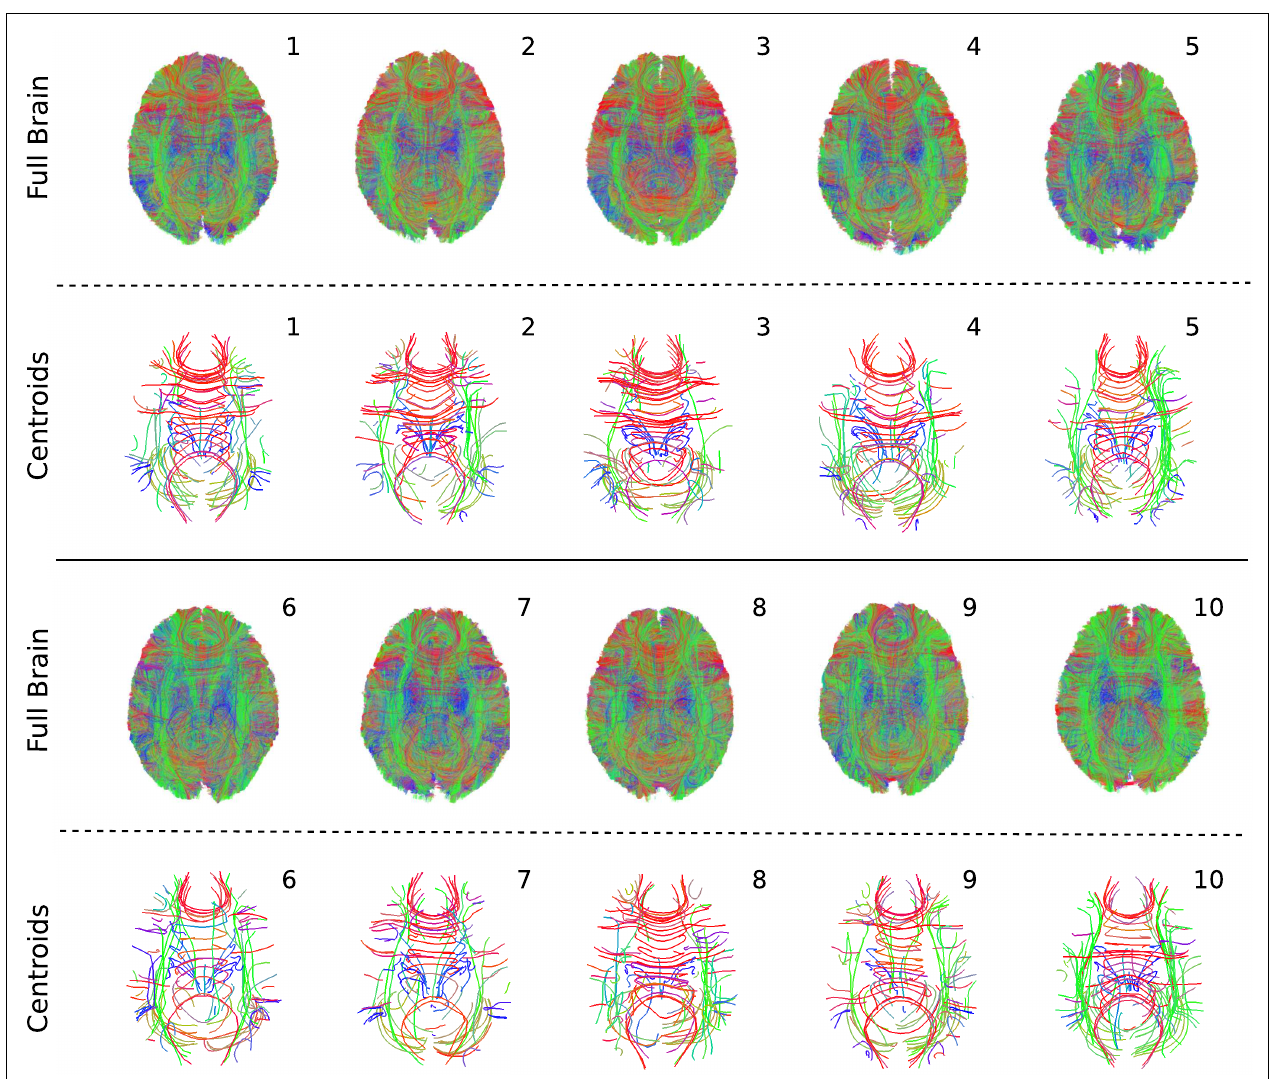
FIGURE 7 | QuickBundles centroids of the biggest 100 clusters for 10 subjects. Full tractographies are also presented using high transparency. All streamlines are visualized with the same standard orientation colormap.